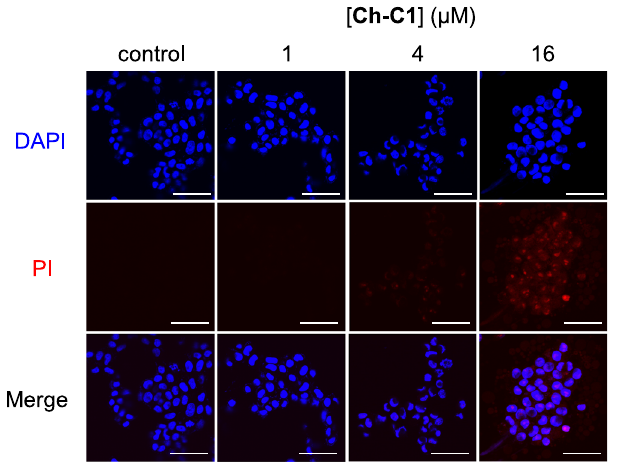
Fig. 4 | Nanopores punch holes on cancer cells. Cell imaging of HepG2 cells treated with Ch-C1 at concentrations of 1 µ M, 4 µ M and 16 µ M for 36h, followed by staining with blue DAPI and red PI dyes. Blue and red images were merged by ImageJ 1.8.0. Each experiment was repeated twice independently with